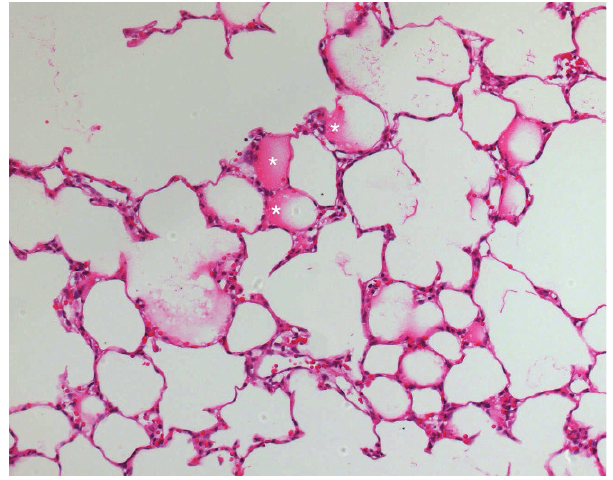
Figure 4 - Histopathology of lungs preserved for 6 hours with Perfadex. Sites of mild alveolar edema can be observed (white asterisks). Similar findings were observed in Celsior-preserved lungs (hematoxylin-eosin, 200X